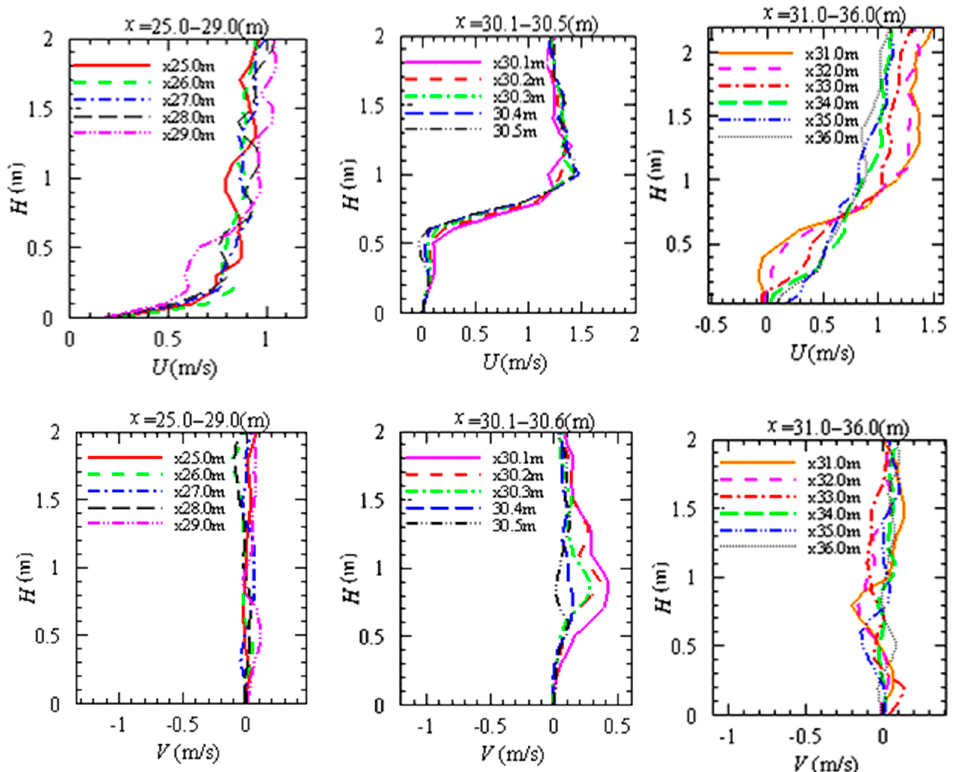
Figure 11. Characteristics of longitudinal and vertical flow fields when the vertical section of the pore is 0.6 m × 0.6 m; solid line: x = 25.0; x = 30.1 x = 31.0; dashed line: x = 26.0; x = 30.2 x = 32.0; dotted line: x = 27.0; x = 30.3x = 33.0. Long dashed line: x = 28.0; x = 30.4 x = 34.0; double dotted line: x = 29.0; x = line: x = 27.0; x = 30.3; x = 33.0. Long dashed line: x = 28.0; x = 30.4; x = 34.0; double dotted line: 30.5 x = 35.0; dotted line: x = 36.0. x = 29.0; x = 30.5; x = 35.0; dotted line: x =